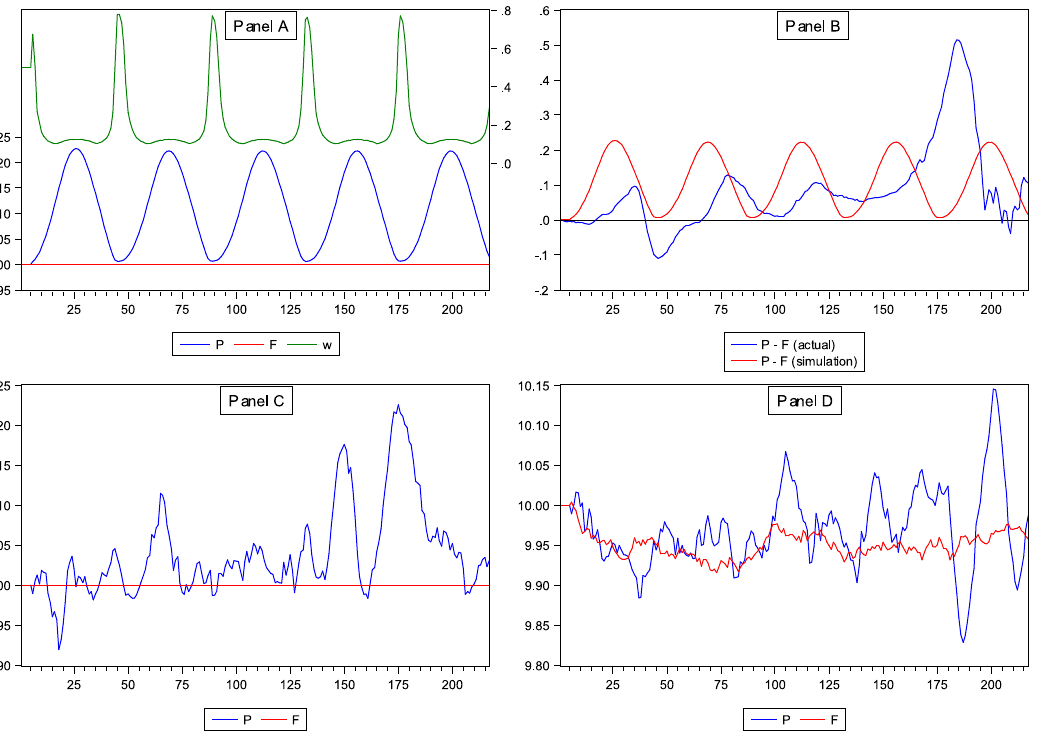
Fig 2. Simulated House Price Index Values. Panel A of Fig 2 displays the simulated behaviour of the log real house price index P t and the proportion of investors applying the fundamentalist forecasting rule ( W t ), using the estimated model parameters. The fundamental value F t is fixed at 10. In Panel B, we display both the simulated and the actual difference between P t and F t . In Panel C we add exogenous random noise to the house price process, and in Panel D we add exogenous noise to both the price process and the fundamental value